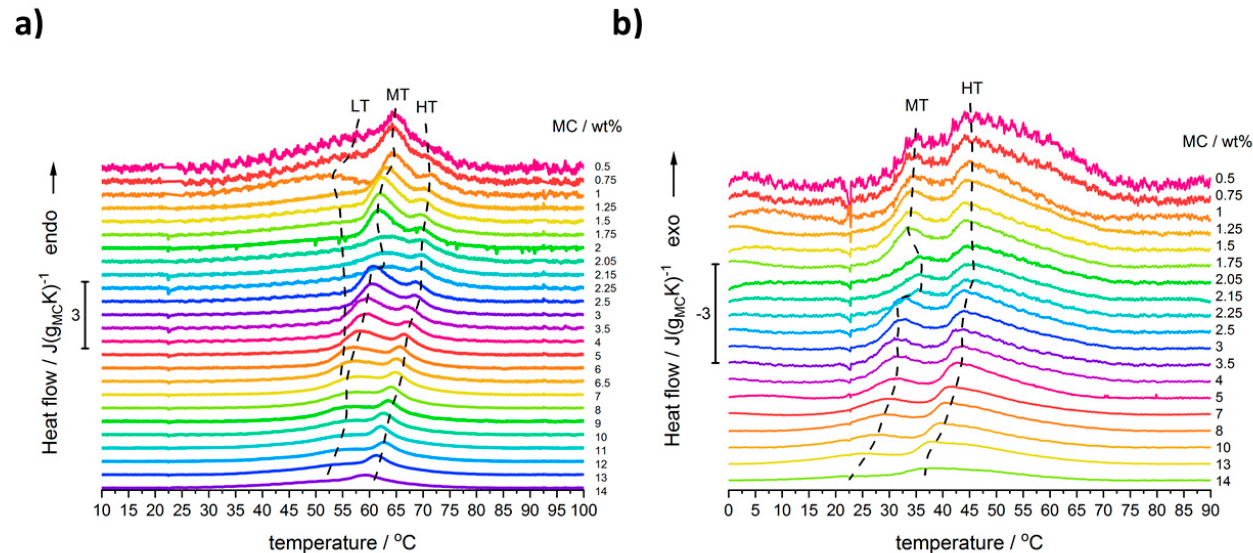
Figure 1. DSC scans registered during: ( a ) heating and ( b ) cooling for solutions of MC at mass content as indicated, normalized to MC mass. Curves shifted in Y-axis for clearness.